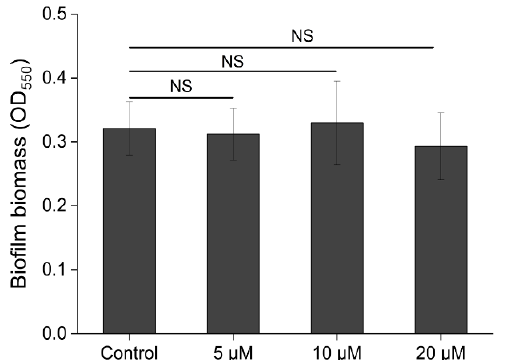
Figure 5. Effect of AHL on the biofilm formation on PE microplastic surface. Error bars were defined as standard deviations (n = 12, biological replicates). One-way ANOVA was performed and the Tukey post hoc test was conducted to compare the AHL treatment to the negative control, where significant differences are indicated as follows: NS, not significant p > 0.05.